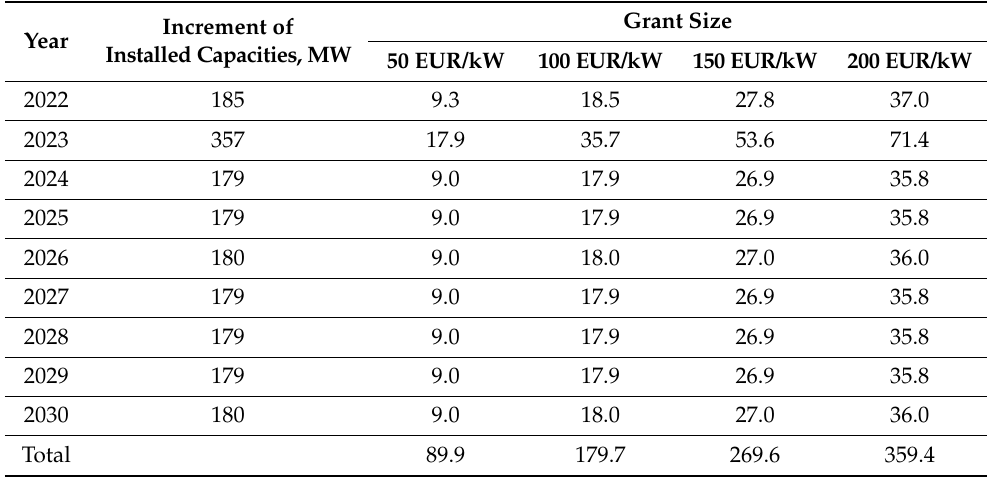
Table 4. Funds needed to ensure investment grants for households and energy cooperatives, EUR 2021 million.